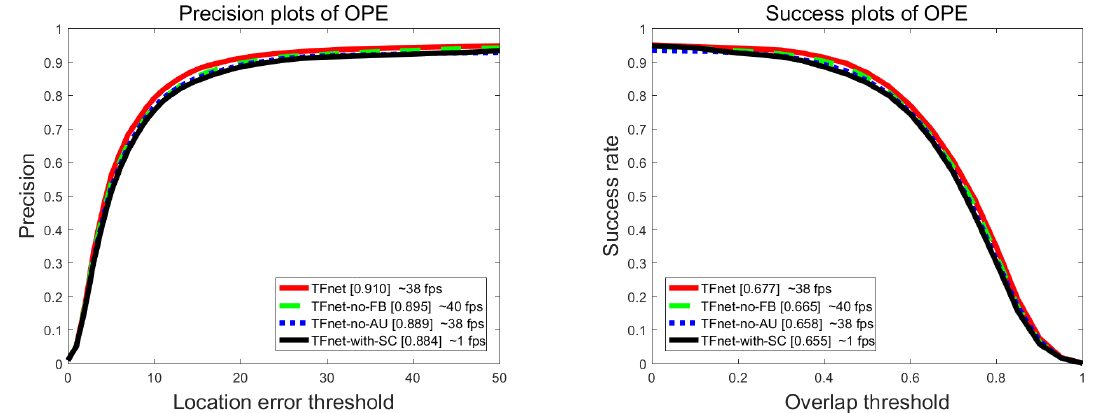
Figure 9. Results of ablation study on the OTB2013